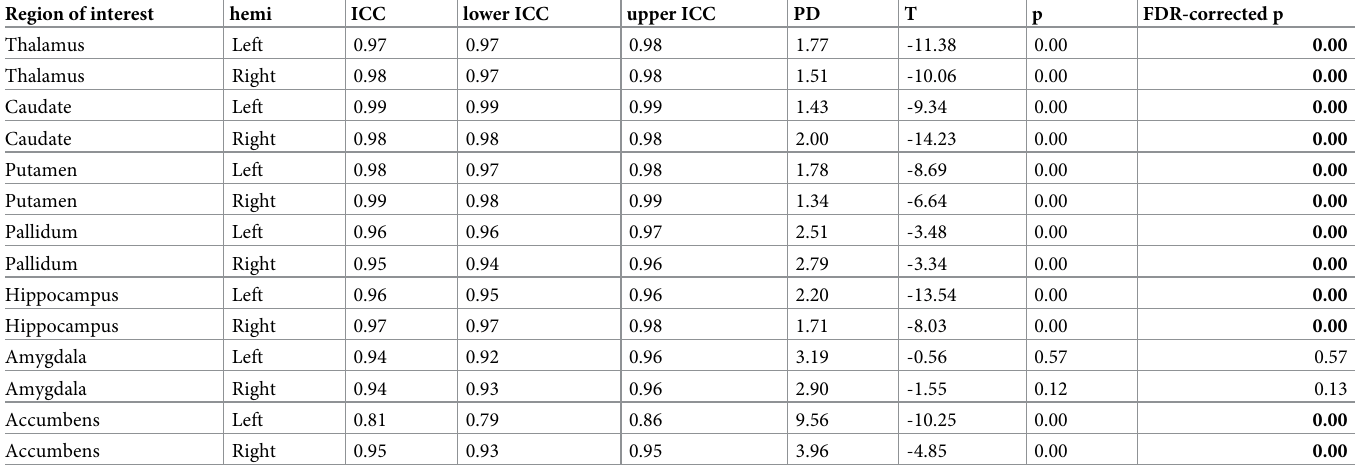
Table 2. Reliability (mean ICC, lower and upper ICC 95% confidence interval) and percent difference (PD) for subcortical grey matter volumes, separated by hemi- sphere (T < 0 reflects Skyra > Verio, T > 0 reflects Verio >